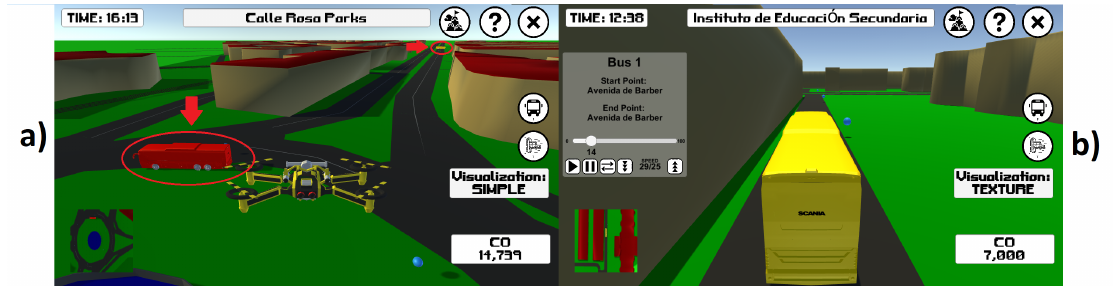
Figure 2. Animated buses and guided driving mode. Two guided buses (indicated by overlaid arrows) circulate the city in ( a ). The user selected one of them and enters in guided driving mode in ( b ). At this point the user automatically follows the animated bus across its